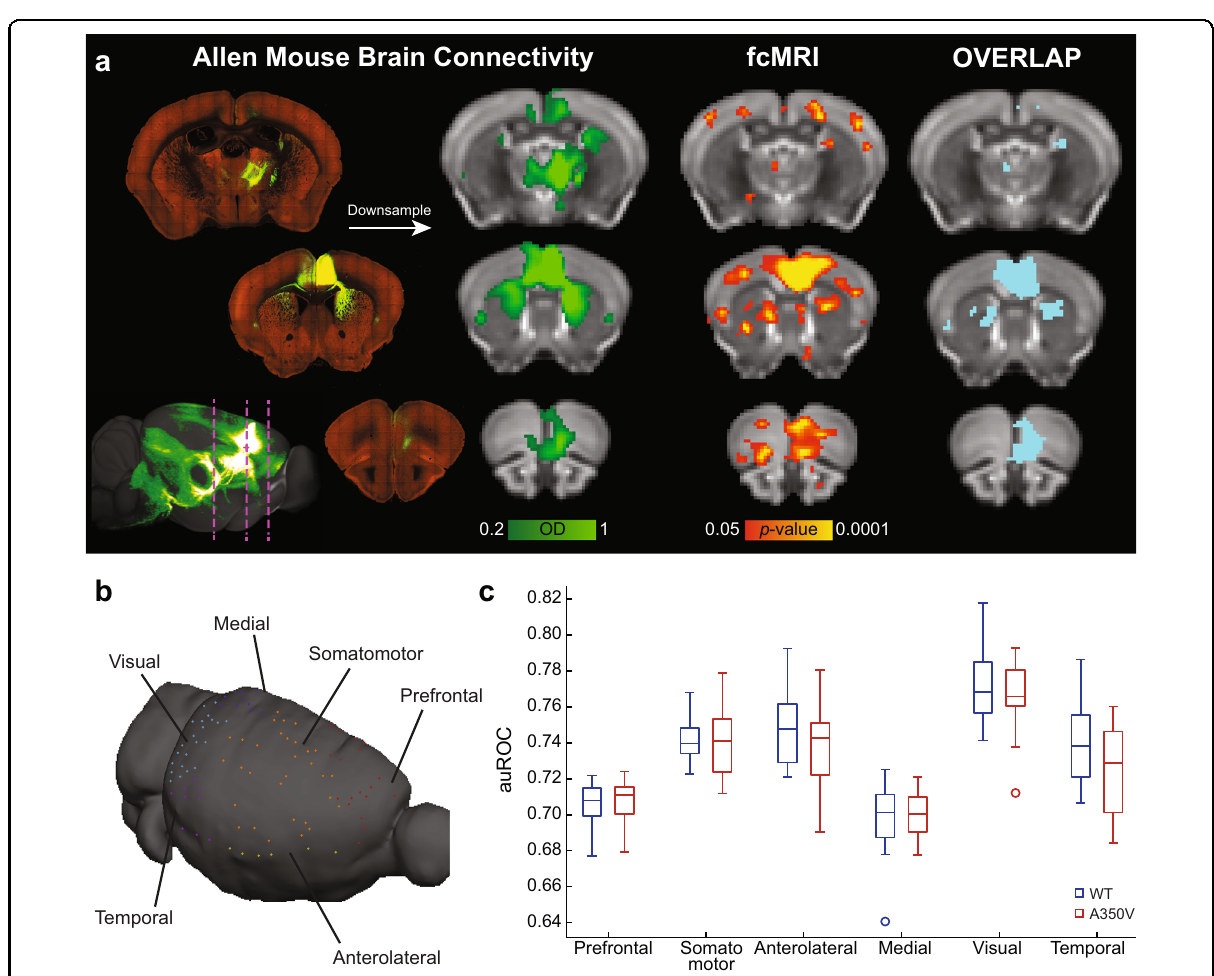
Fig. 3 Structure – function relations of the six cortical modules. a Analysis scheme for comparing structure – function relations using MRI shown for Allen mouse brain connectivity (AMBC) atlas experiment #112514202, ACAv injection. Three representative coronal slices showing multiple anatomical connections ( top , left ) in AMBC space and a maximum intensity projection sagittal view of signal density ( bottom, left ). Approximate locations of the presented coronal sections are indicated by magenta dashed lines. The arrow indicates the corresponding downsampled coronal slices (optical density, [OD] in green-light green, normalized OD > 0.2). An fcMRI statistical parametric map (in red - yellow ) of positive correlations of ACAv on a downsampled version of the AMBC Atlas that matches the original fMRI resolution; p < 0.05, corrected for multiple comparisons using family-wise error rate correction for the whole mouse brain. Overlap of functional and anatomical connectivity ( pale blue ) demonstrates a close agreement across the two modalities. b The seeds corresponding to AMBC tracer injections are illustrated on a mouse cortical surface. Seeds are color coded for the six cortical modules. c The six cortical modules auROC values demonstrate equivalent structure – function relations between the two groups for all modules. n = 13 per group; Boxplots represent the median (center line), interquartile range (box limits), extreme data points (whiskers), and outlier